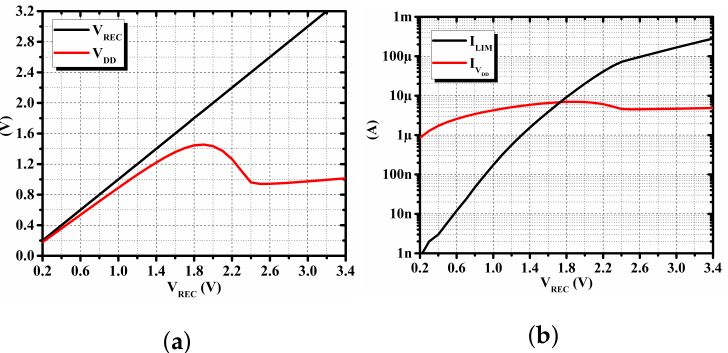
Figure 19. Shunt regulator post-layout simulations. ( a ) Output voltage. ( b ) Delivered current.